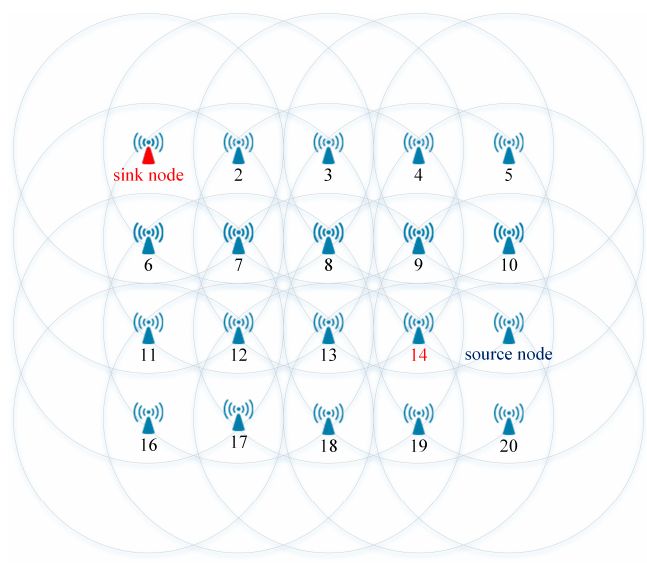
Figure 9. The sample wireless sensor network (WSN) used in Simulation 1.